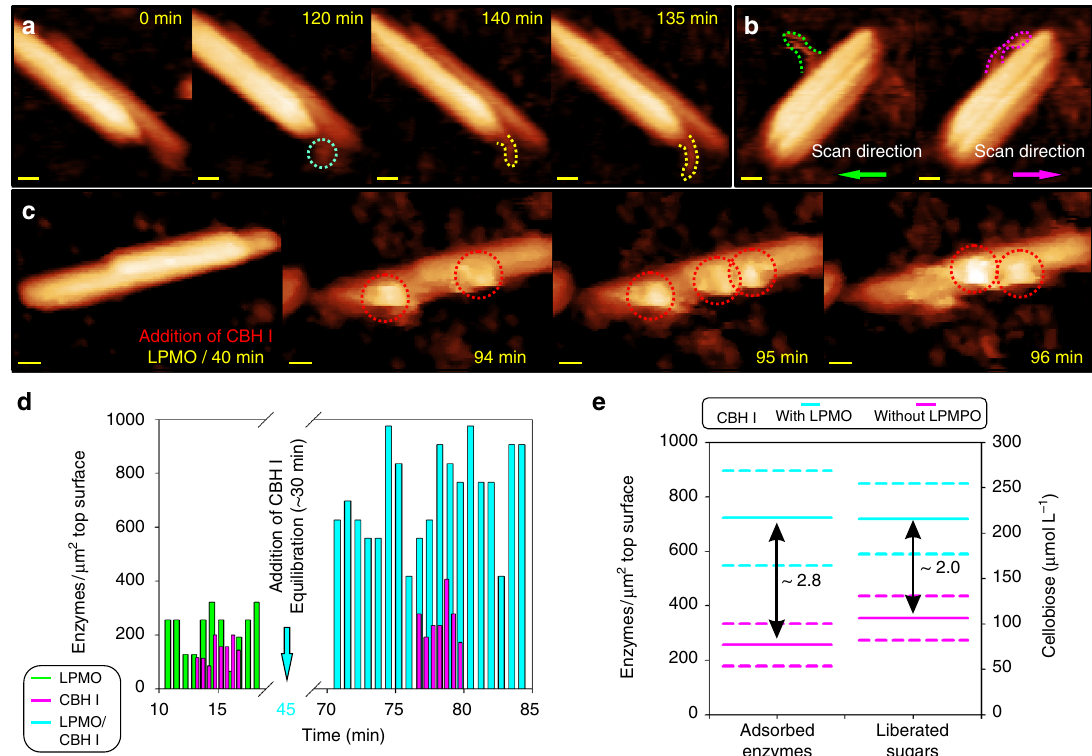
Fig. 3 Real-time observations of LPMO activity on cellulose nanocrystals and its effect on CBH I. a Partial detachment of cellulose fi brils from nanocrystals as a result of C1 oxidizing LPMO activity. LPMO molecule adsorbs (blue circle) to an intact crystal and after desorption a fi bril loosened from the crystalline material (yellow frame) becomes visible. b By comparing forward (trace; green frames) and backward direction (retrace; blue frames) of AFM line scans, the loosened parts of the fi brils are shown to be moveable by the AFM tip. The fi bril part associated with the cellulose nanocrystal, by contrast, was not moveable. Further examples of cellulose nanocrystal fi brillation by LMPO are shown in Supplementary Fig. 3. c LPMO enhances the adsorption of CBH I to cellulose nanocrystals, as shown in AFM images (compare ( c ) and Fig. 1b) and quantitative single-molecule analysis ( d ). d The ratio of enzyme molecules/ top surface area analyzed for 16 cellulose nanocrystals is shown for the conditions that LPMO acted alone and CBH I was added afterwards. Experiment using CBH I alone is shown as reference. Real-time observations are also shown in Supplementary Movies 5 and 6. Besides showing enhanced enzyme adsorption, the movies reveal an increased portion of the adsorbed enzymes to be mobile on the cellulose surface when LPMO and CBH I were present together. Supplementary Movie 2, which shows CBH I acting alone, is used as reference. e Synergy between CBH I and LPMO during degradation of cellulose nanocrystals is shown. LPMO addition stimulated the CBH I adsorption and resulted in increased release of soluble sugars. Solid lines represent mean values and standard error is indicated by dashed lines. All scale bars are 10